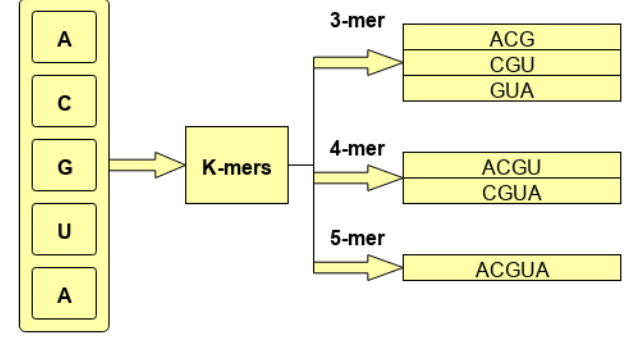
Figure 1. Process of k-mer